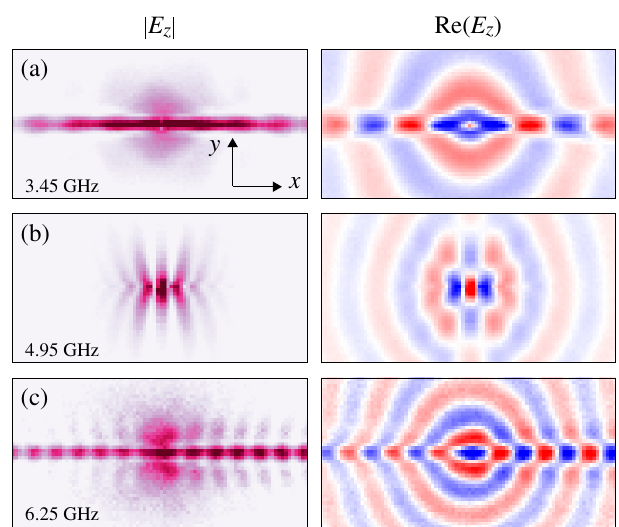
FIG. 9. Spatial distribution of the absolute value (first column) and real part (second column) of the measured normal electric field component for the canalized quasi-TM surface waves. The scanning area of the structure consists of 48 × 24 unit cells ( 336 × 168 mm 2